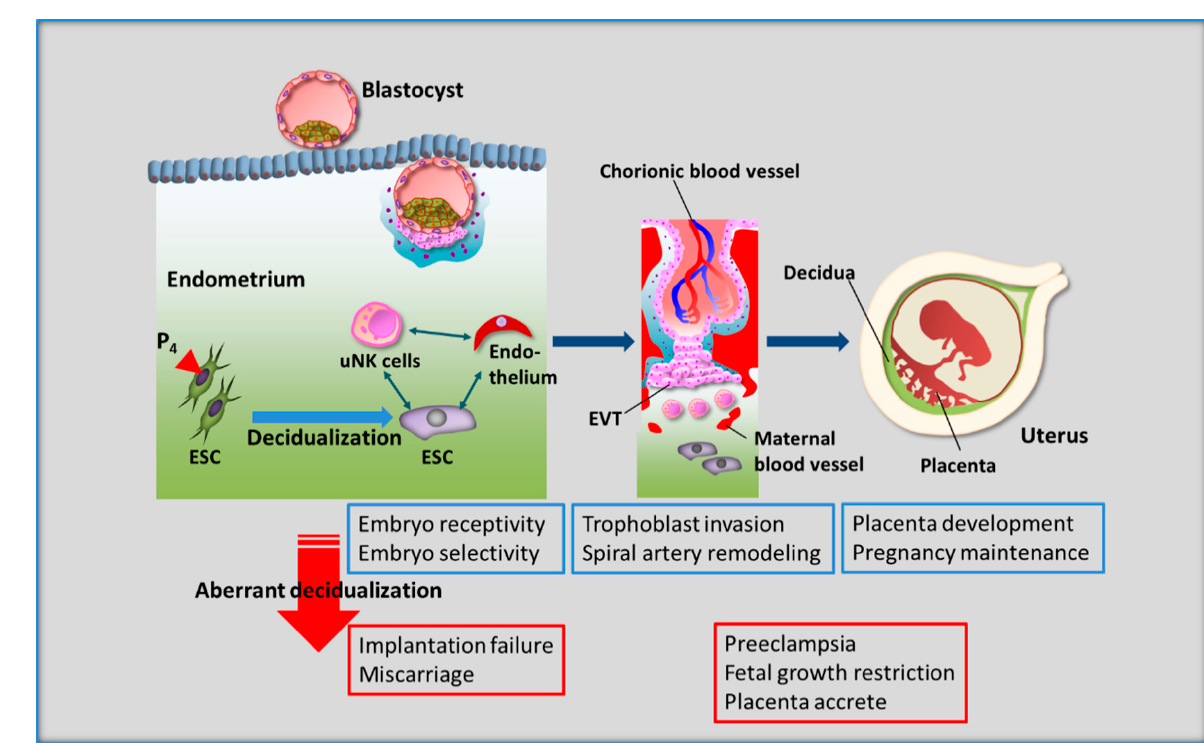
Figure 2. Decidualization of human endometrial stromal cells (ESCs) is essential for reproductive success. During the secretory phase, decidualized ESCs interact with all cells in the endometrium, including uterine natural killer (uNK) cells, which are representative local immune cells, vascular endothelial cells, and blastocysts. This decidual process leads to successful pregnancy, i.e., embryo implantation, balanced trophoblast invasion, spiral artery remodeling, establishment of the placenta, and the maintenance of pregnancy. Therefore, aberrant decidualization results in reproductive and perinatal impairment, including implantation failure, miscarriage, preeclampsia, fetal growth restriction, and placenta accreta. EVT, extravillous trophoblast cell.